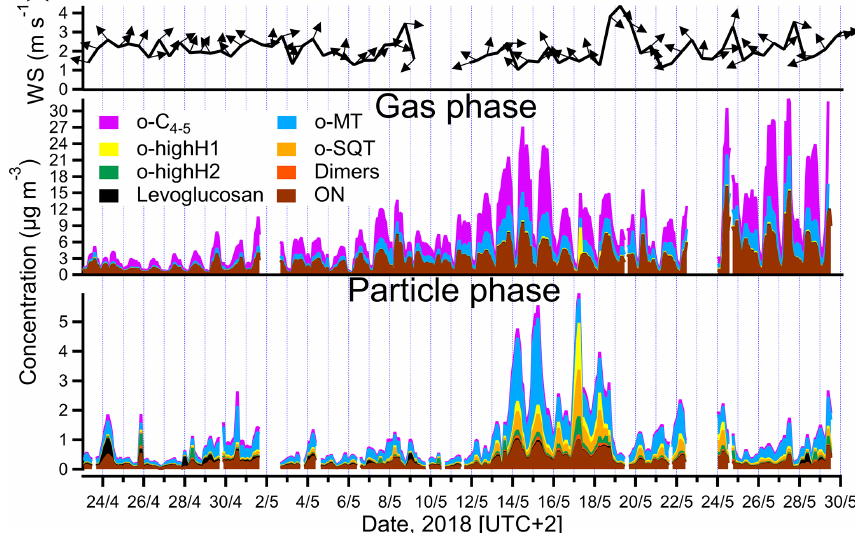
Figure 3. Total mass concentrations of different groups of analytes measured in the gas and particle phases (middle and lower panels) by FIGAERO-CIMS and summed all over the groups listed in Table 1, and wind speed and wind direction (upper panel, 12h averaged). The group of other measured compounds is excluded for clarity (note that o-highH1 and/or o-highH2 could be misidentified o-SQT/dimers; see text for